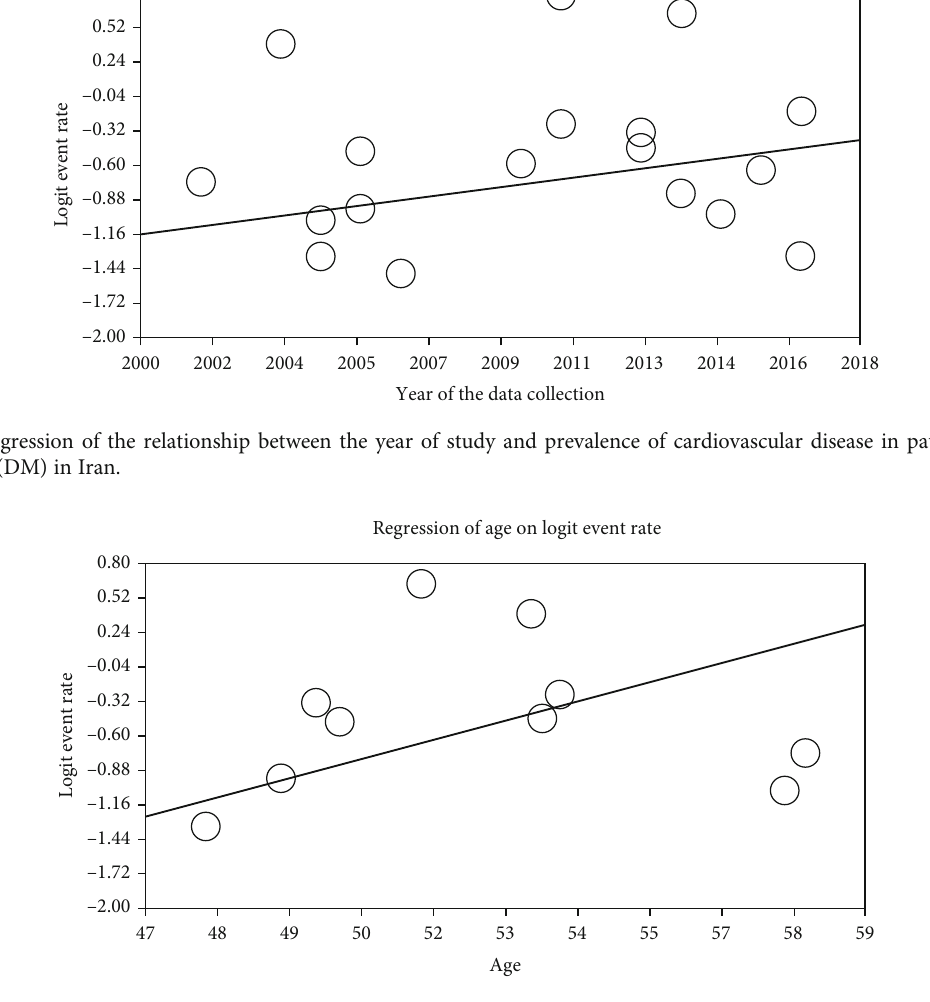
Figure 7: Metaregression of the relationship between the age of participants in the study and prevalence of cardiovascular disease in patients with type 2 diabetes mellitus (DM) in